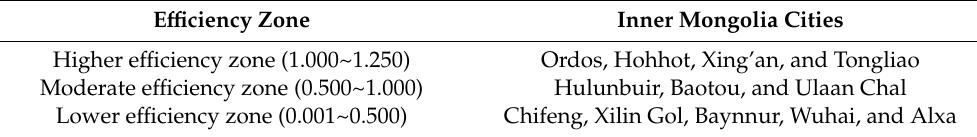
Table 3. The results of the k-means clustering analysis.